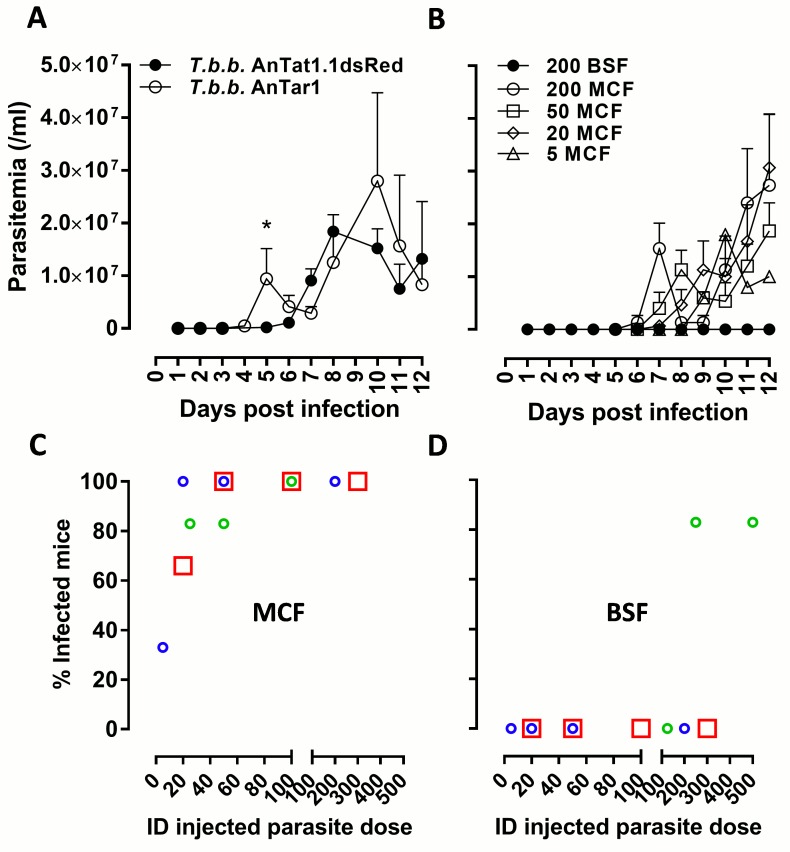
Effect of trypanosome dose on intradermal infection.(A) Parasitemia development in peripheral blood of mice (n = 5/group) naturally infected by the bites of T.b.brucei AnTAR1 (empty symbols) and T.b.brucei AnTat1.1EdsRed infected tsetse flies (filled symbols) with respectively a high and low number of parasites in the salivary glands. (B) Parasitemia progression in peripheral blood of mice (n = 3/group) intradermally inoculated with varying numbers of metacyclic parasites (200, 50, 20 and 5 MCF) extracted from SG+ G.m.morsitans tsetse flies versus 200 purified bloodstream (BSF) T.b.brucei parasites. These data are representative of 3 independent experiments. Infection rates are recorded following intradermal needle inoculation of varying numbers of (C) washed (round symbols) or DEAE52-purified (red squares) metacyclic (MCF) T.b.brucei parasites isolated from tsetse salivary glands (n = 3 or 6 for each parasite dose and experiment, totaling 48 mice) and (D) DEAE52-purified bloodstream (BSF) T.b.brucei parasites (n = 3 or 6 for each parasite dose and experiment, totaling 42 mice). The parasitological status was checked for 14 days following parasite inoculation. Different symbol colours indicate the 3 independent infection experiments. Different sizes of the symbols are to avoid overlaps. Red squares correspond to the BSF infection rates calculated from the infection experiment that also included the DEAE52-purified MCF parasites as shown in panel C. Data are shown as the mean ± SEM.